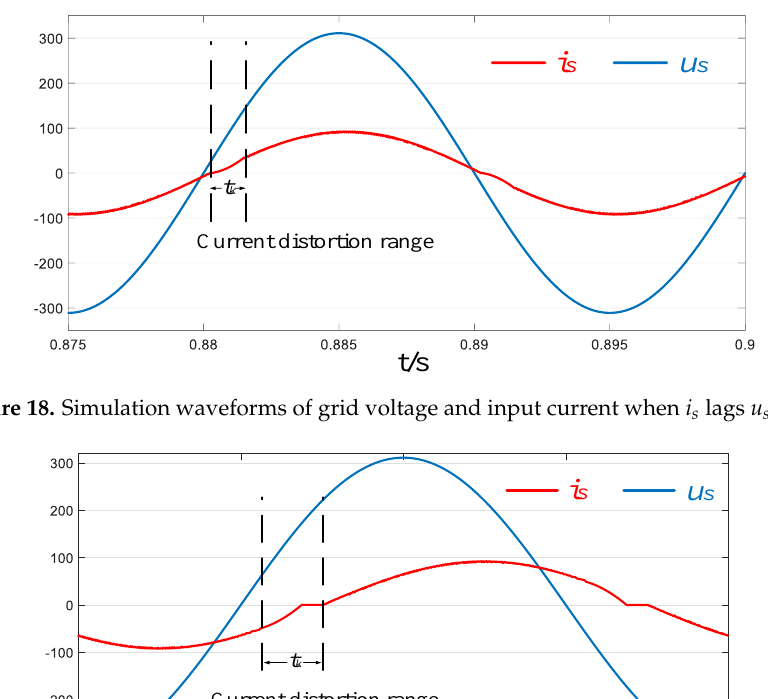
Figure 17. Simulation waveforms of grid voltage and input current under leading power factor.